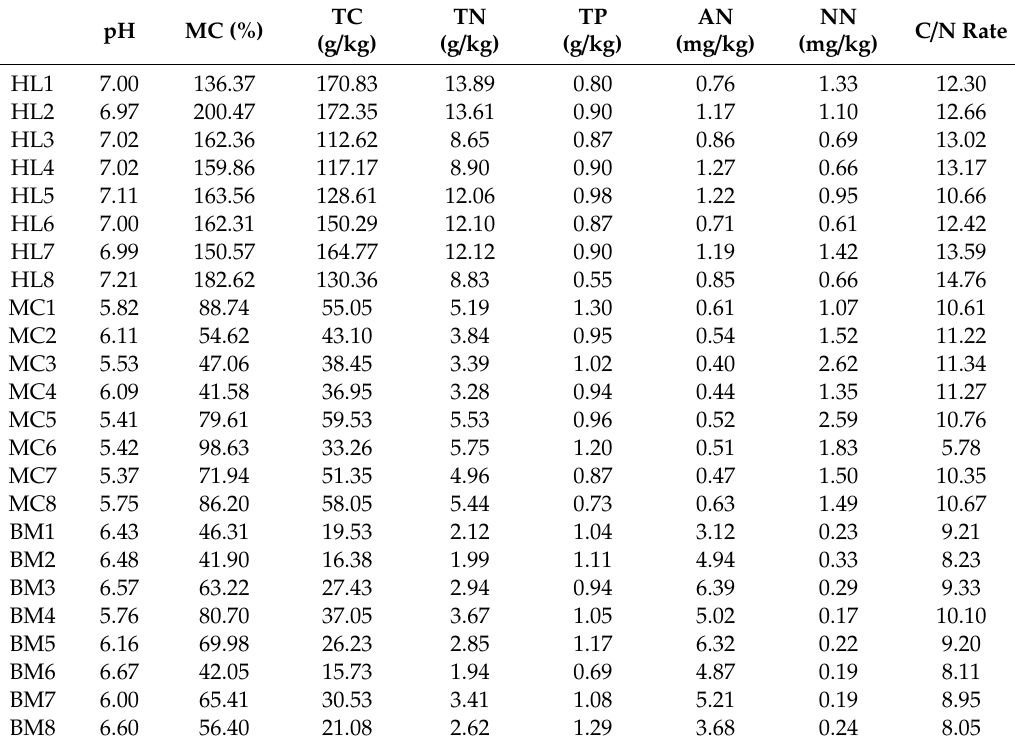
Table 1. Soil properties of samples from Huahu Lake Wetland, Mangcuo Lake Wetland and Baima Snow Mountain